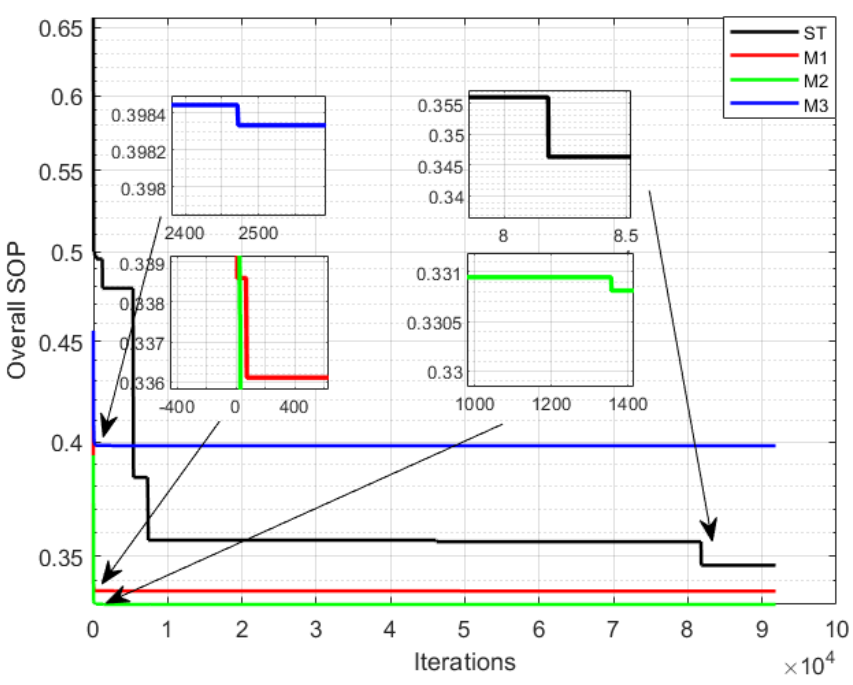
Figure 5. Iterative convergence rate of SA